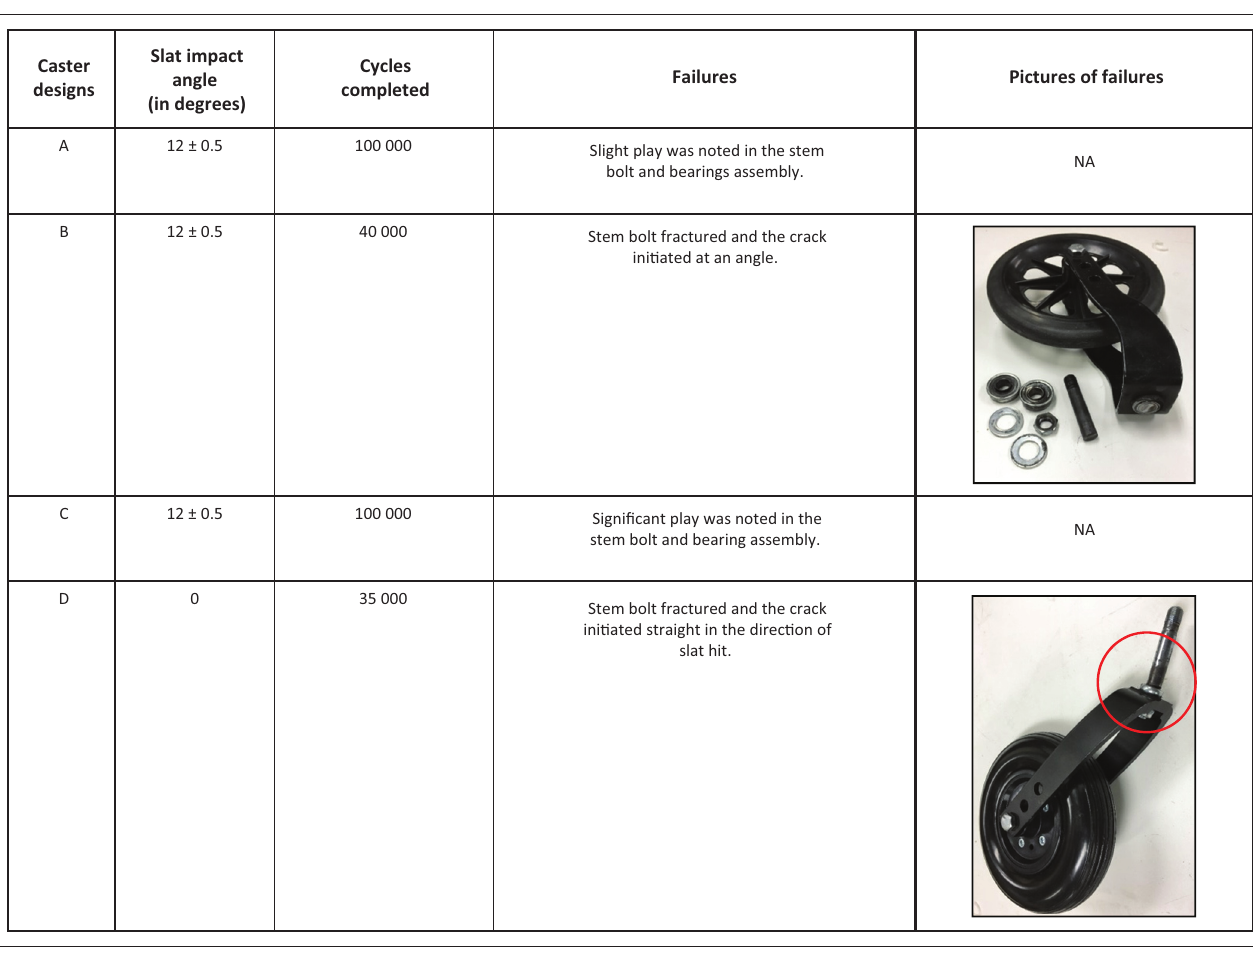
FIGURE 14: Results from initial testing of caster assemblies.